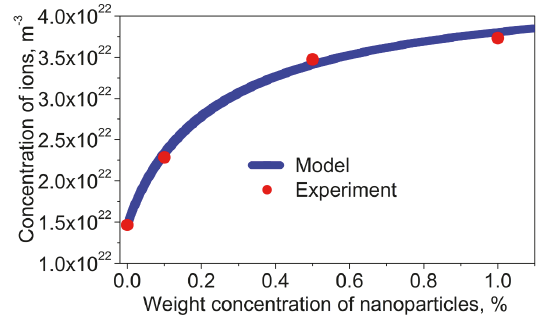
Figure 5: The concentration of ions in liquid crystals doped with Cu 7 PS 6 nanoparticles as a function of the weight concentration of nanodopants. The presented model (solid curve) is in good agreement with reported experimental data points (circles) [36]. Physical parameters used in simulations: 𝜎 𝑁𝑃 𝑆 = 7×10 18 𝑚 −2 , 𝐾 𝑁𝑃 = 10 −23 𝑚 3 , 𝑛 = 1.466 × 10 22 𝑚 −3 , ] = 0.3075 , 𝑅 = 58.5 𝑛𝑚 , 0 𝑁𝑃 𝑁𝑃 𝜌 /𝜌 = 4.907 , 𝑞 = 3.2 × 10 −19 𝐶 , and 𝜇 = 10 −10 𝑚 2 /𝑉 × 𝑠 𝑁𝑃 𝐿𝐶